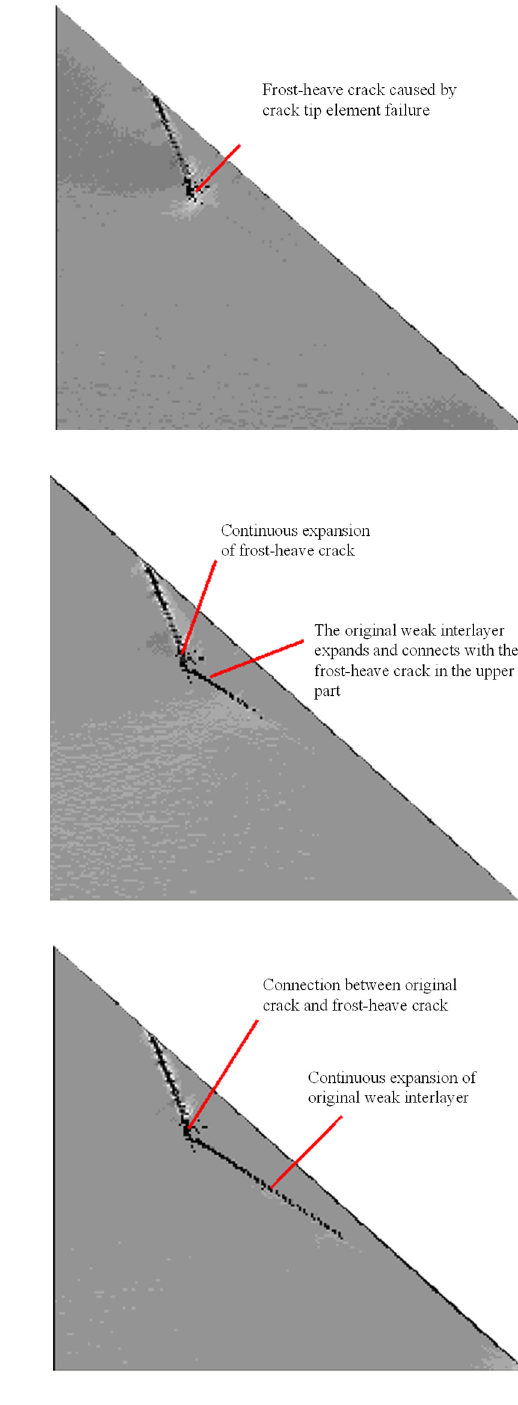
Figure 11. Evolution diagrams of the minimum principal stress σ 3 for the slope model: ( a ) 1 h; ( b ) 5 h; ( c ) 10 h; ( d ) 15 h; ( e ) 20 h.